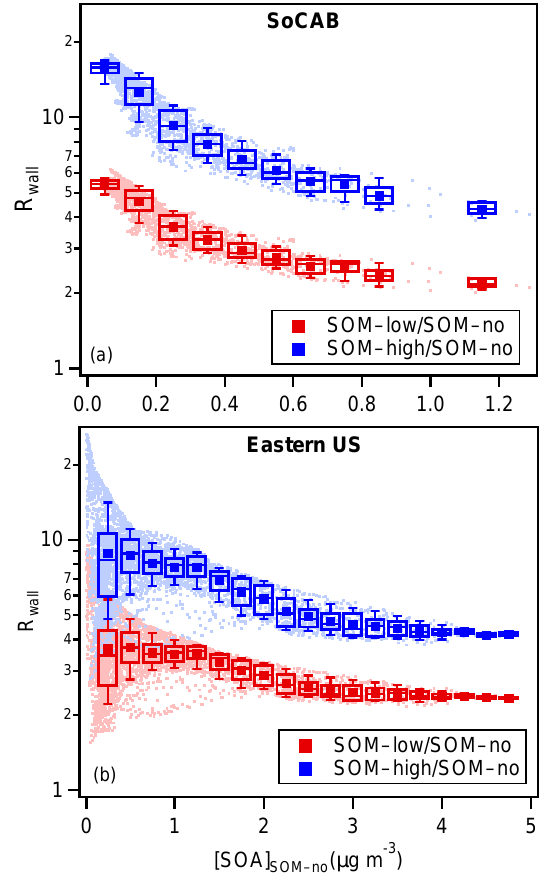
Figure 2. Variation of the ratio between simulated SOA concen- trations from SOM-low (red) and SOM-high (blue) simulations to SOM-no simulations for (a) SoCAB and (b) the eastern US as a function of the absolute SOA concentration from the SOM-no sim- ulations. Results shown are the average of the low- and high-NO x simulations. Individual data points are shown along with box and whisker